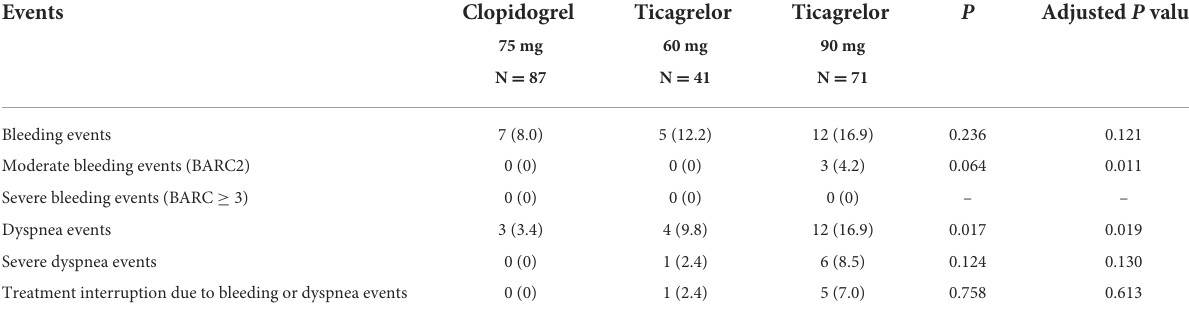
TABLE 3 The occurrence of bleeding and dyspnea events in ACS